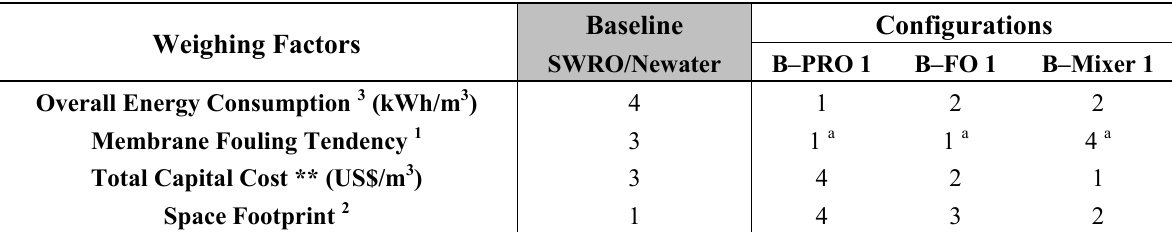
Table 2. Decision Matrix